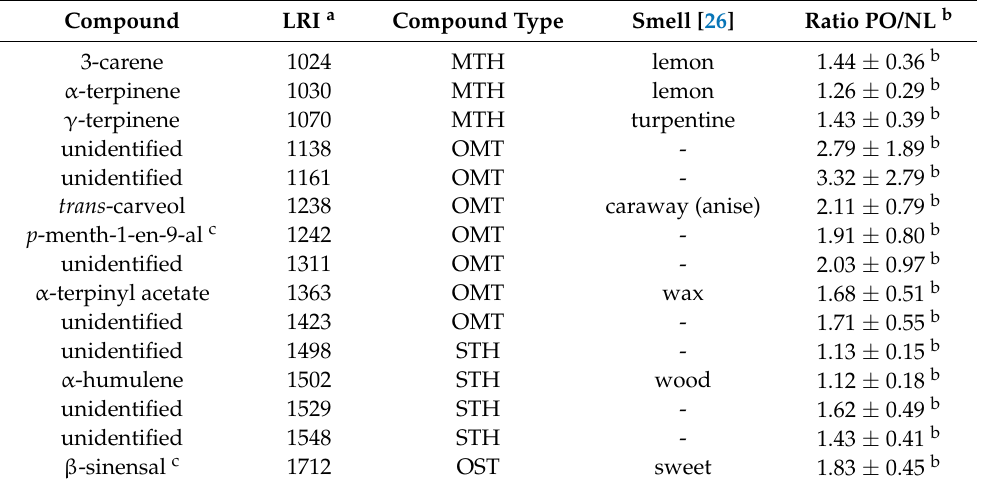
Table 1. Volatile Organic Compounds more abundant in Clemenpons (PO) than in Clemenules (NL). Compound LRI a Compound Type Smell [26] Ratio PO/NL b 3-carene